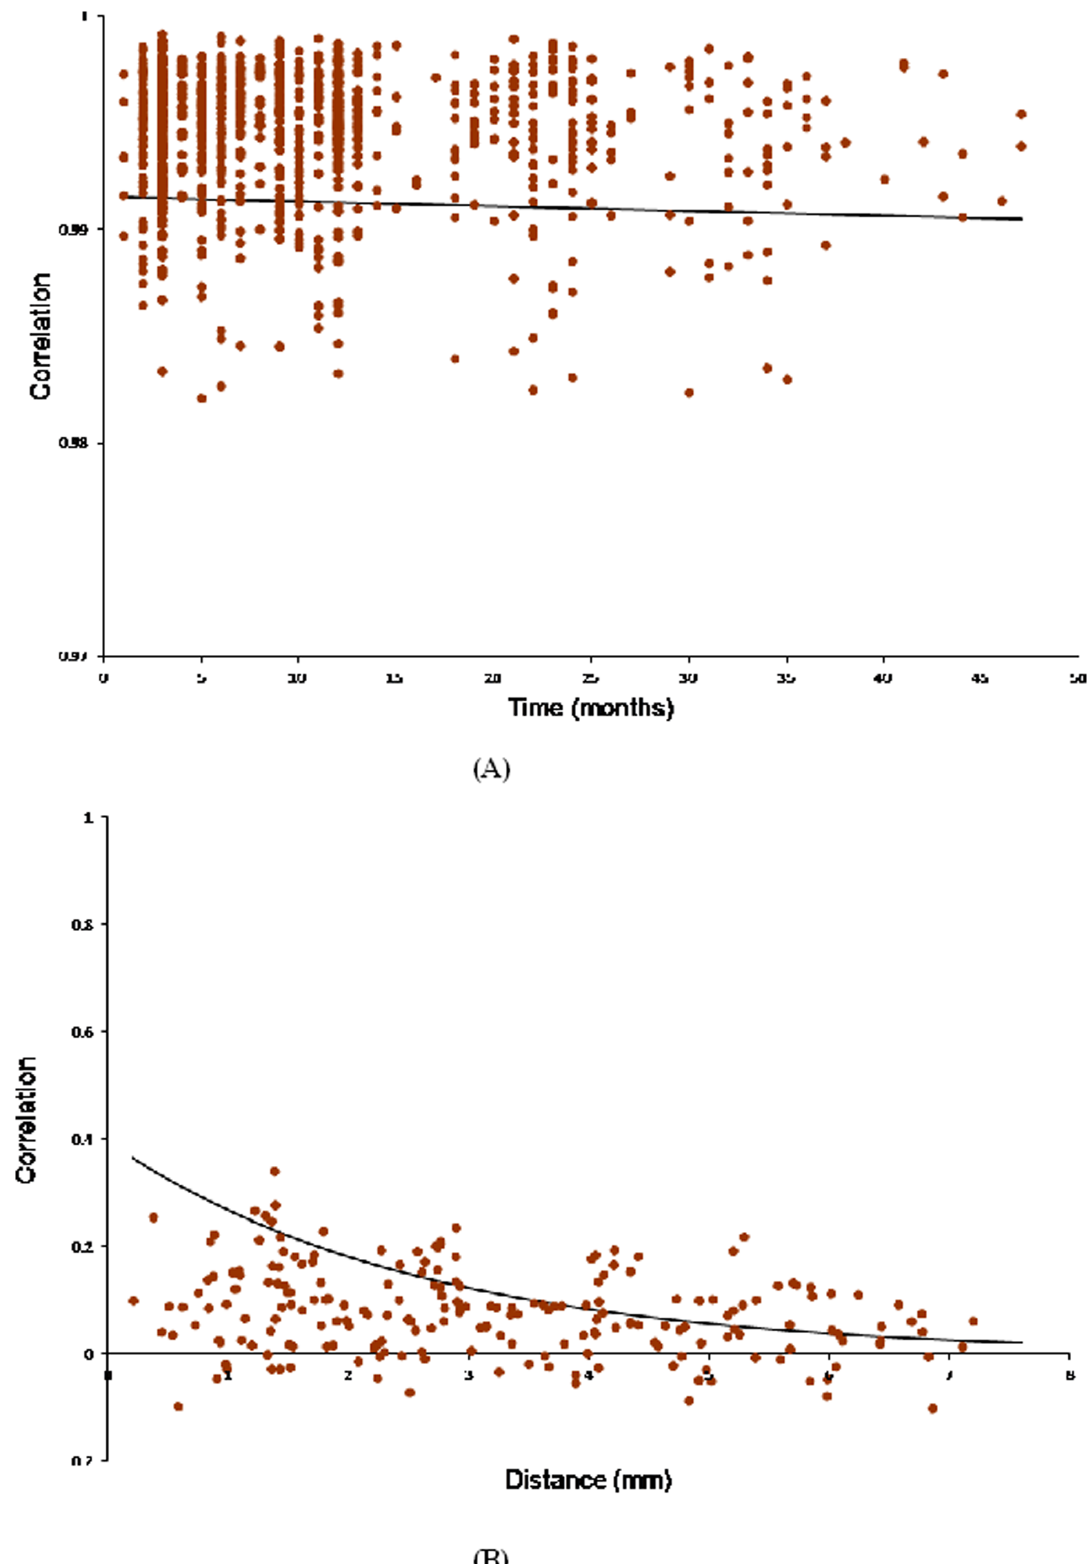
Figure 4. Observed (dots) vs. predicted (curve) correlation. ( A ) as a function of the time between images; ( B ) as a function of the distance between radius locations.